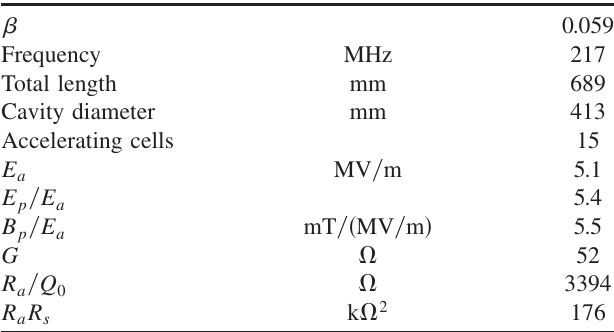
TABLE III. Parameters of the first superconducting CH cavity for the heavy ion